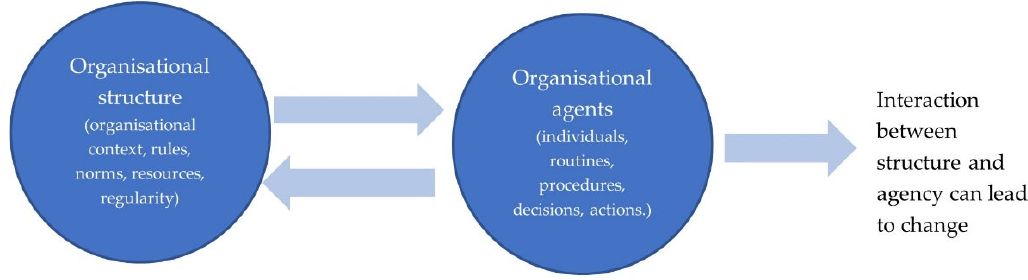
Figure 9. Interaction between structure and agent, leads to change, adapted from